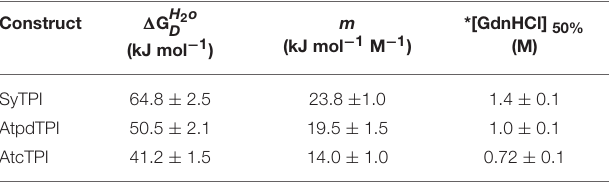
TABLE 4 | Thermodynamic parameters for unfolding data of SyTPI, AtcTPI, and AtpdTPI according to a two-state dimer denaturation model.